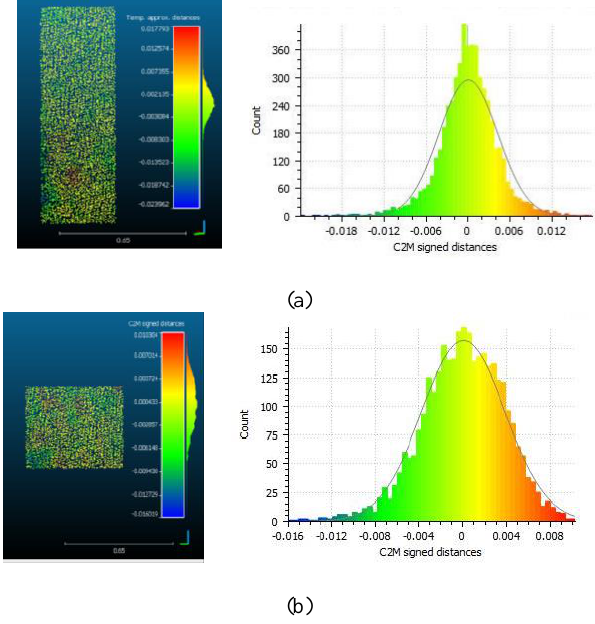
Figure 6: Plane fitting for two Photoscan subsets The Photoscan data has relatively less planarity compared to the laser scanner data. Subset one has 5,450 points/unit area, and subset two has 3,276 points/unit